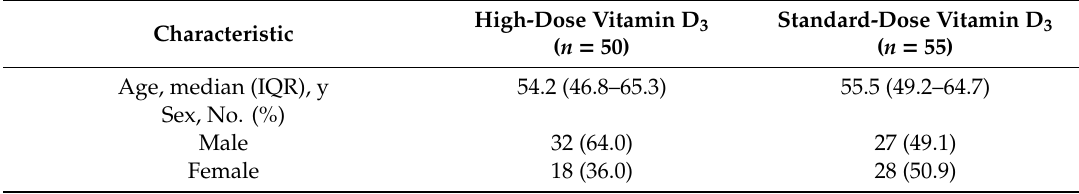
Table 1. Baseline characteristics of sub-study participants by randomized group.